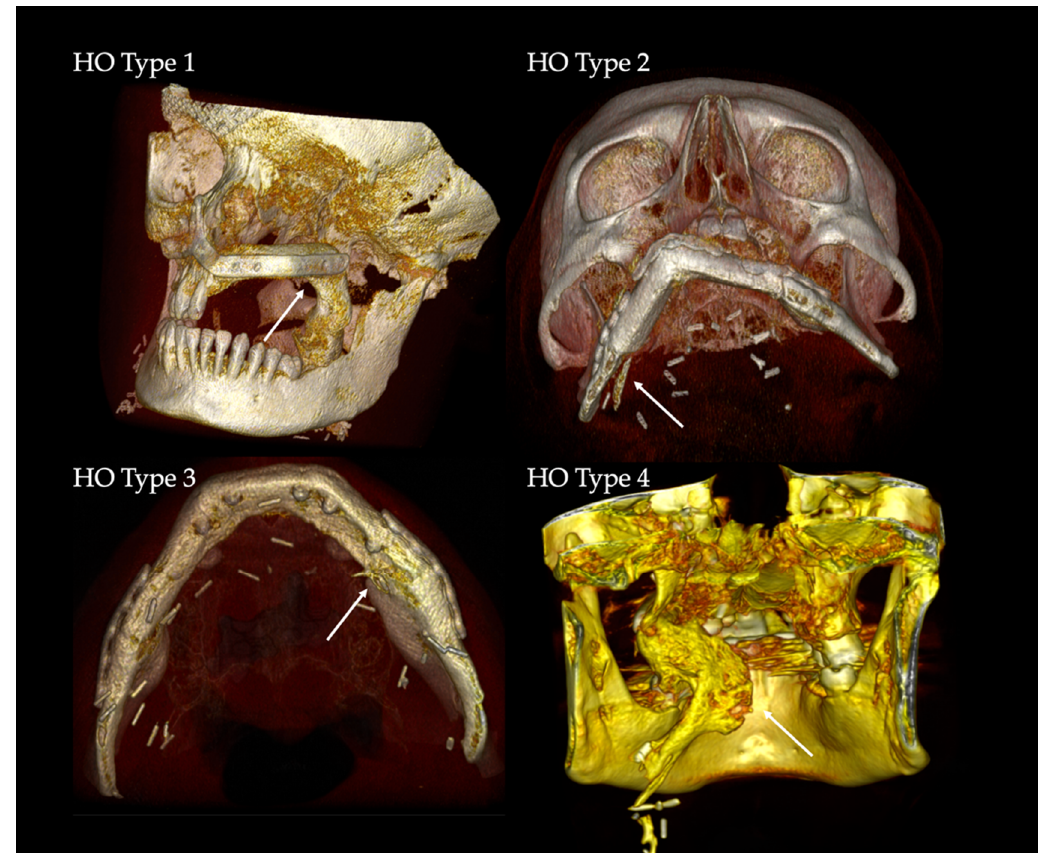
Figure 2. 3D-volume rendering of clinical examples of HO Types 1–4. The white arrows mark the regions of interest.